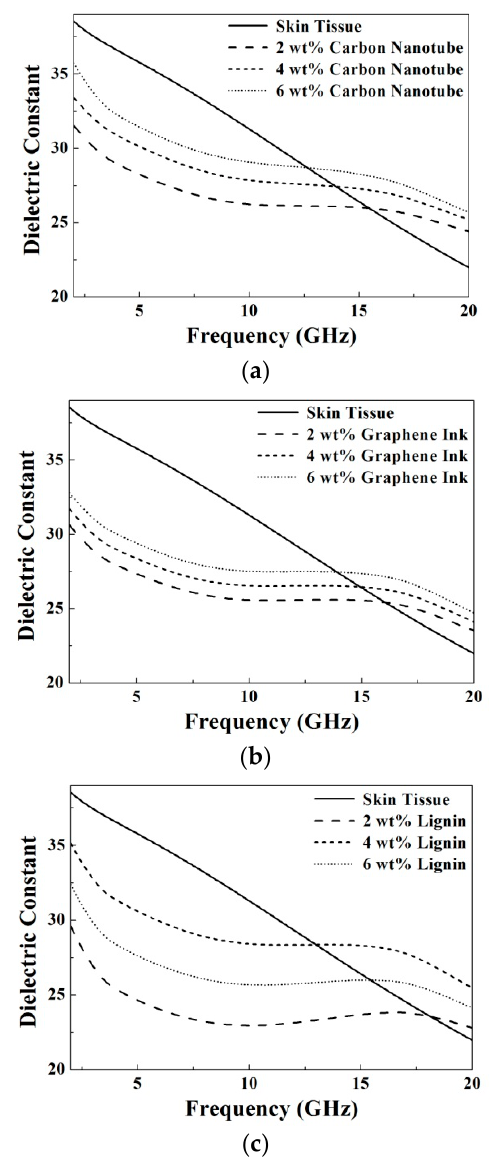
Figure 10. Comparison of dielectric constants between the skin tissue and the prepared samples with different doping concentrations of ( a ) carbon nanotube; ( b ) graphene ink and ( c ) lignin.